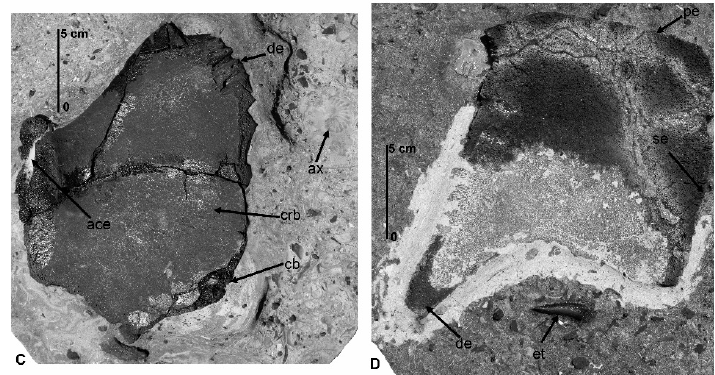
Figure 7. Turtle plastral elements from the basalmost Midway Group lag deposit Hot Spring County, Arkansas. ( A ) Partial plastron (NJSM GP23417) in exterior view; ( B ) partial plastron (NJSM GP23627) in exterior view; ( C ) partial plastron (NJSM GP23418) in interior view; ( D ) partial plastron (NJSM GP23412) in interior view. Scale bars in A – D = 5 cm. Abbreviations: ace: acetabulum, ax: ammonite